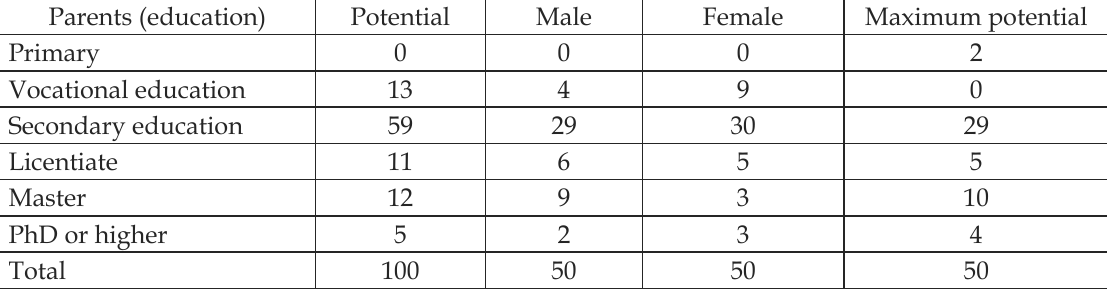
Table 6 . Educational level of parents of